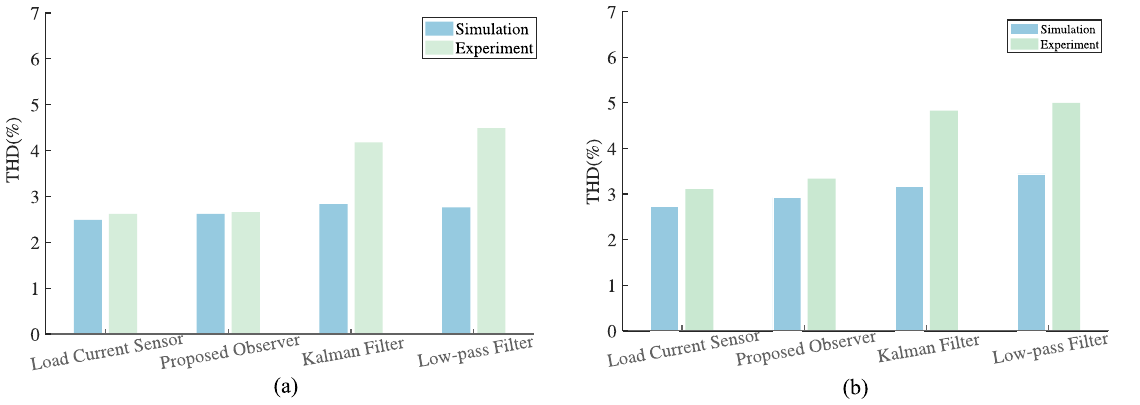
Figure 12. Comparison of simulation and experimental output voltage THD values: ( a ) linear load, ( b ) nonlinear load.